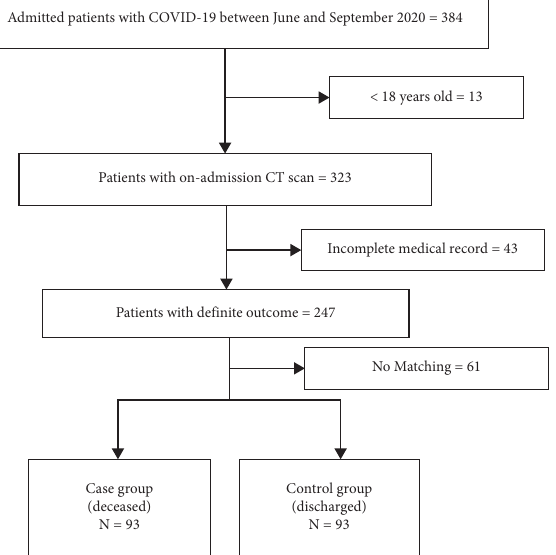
Figure 1: Flow diagram of the